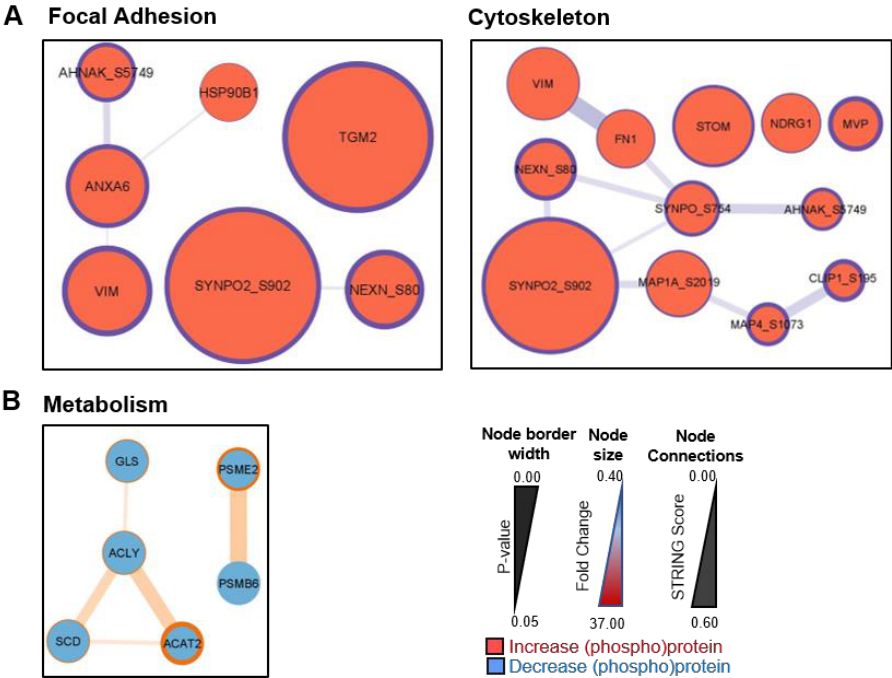
Figure 5. STRING/Cytoscape network analysis of differentially regulated BPH-1 proteins and phosphosites. Enriched signalling networks of ( A ) increased and ( B ) decreased BPH-1 (phospho)proteins in CAF co-culture. Node size is representative of protein expression fold change (co-culture/monoculture); node border width is representative of the p -value for co-culture/monoculture comparison for each protein; node connection line thickness is representative of STRING score between connected proteins.